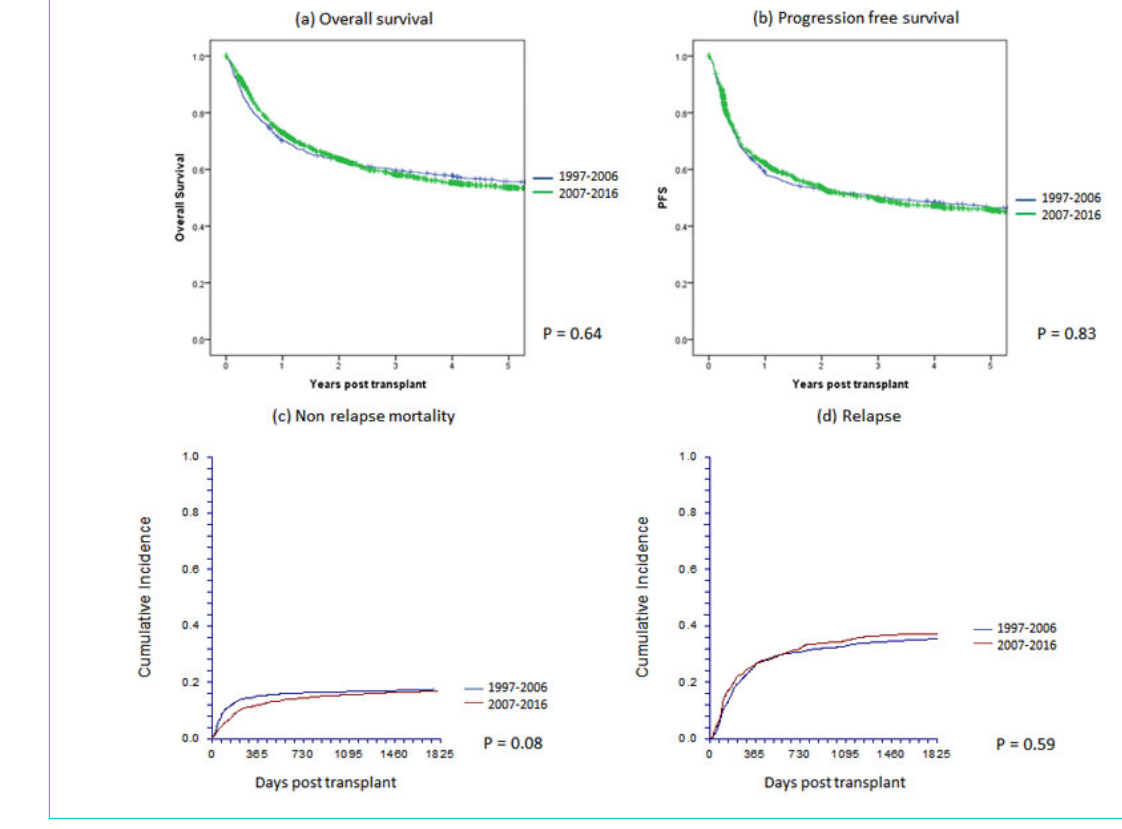
Figure 1: Main outcomes of 2781 patients with allogeneic haematopoietic cell transplants by year group in Switzerland between 1997 and 2016: (a) overall survival, (b) progression-free survival, (c) nonrelapse mortality and (d)